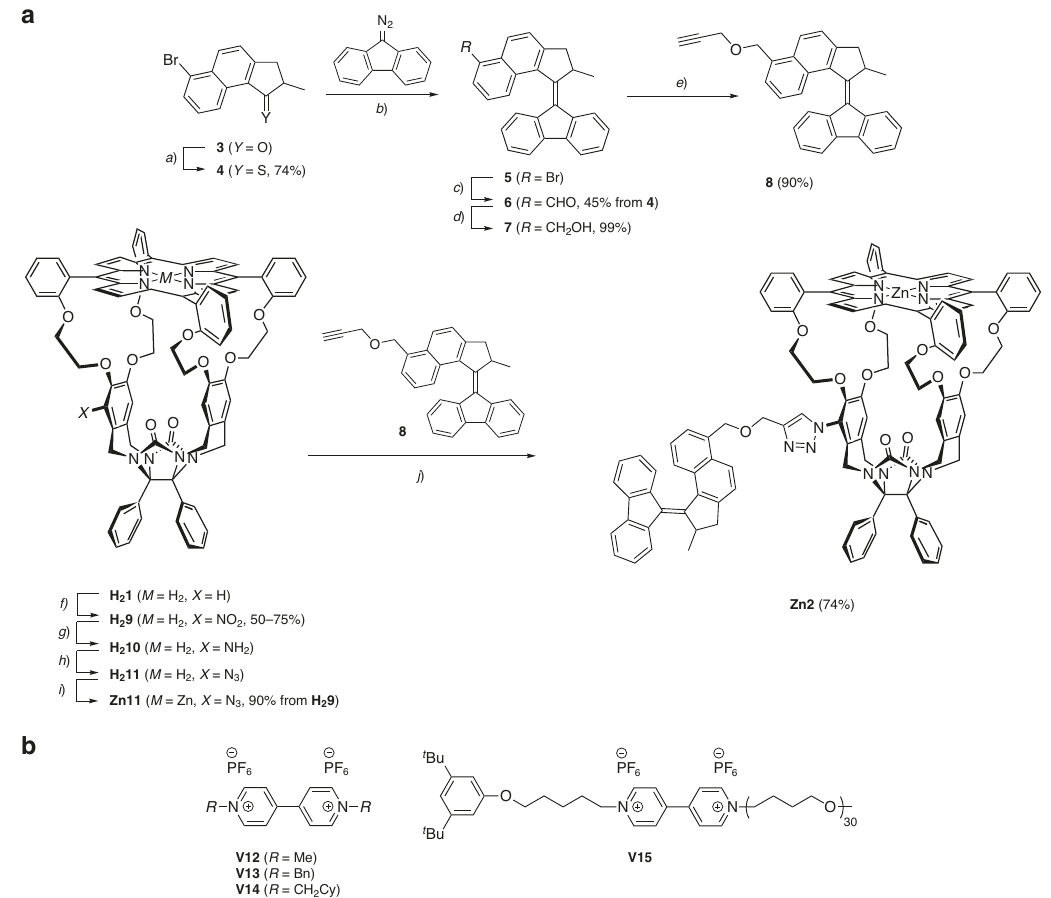
Fig. 2 Synthesis and chemical structures of motor-porphyrin macrocycle conjugate and guests. a Synthesis of Zn2 . Reagents and conditions: a Lawesson ’ s reagent, PhMe, re fl ux, 2 h; b PhMe, re fl ux, 16 h; c n BuLi, THF, − 78 °C, 1 h; then DMF, THF, − 78 °C → 20 °C, 1 h; d NaBH 4 , DCM/MeOH, 20 °C, 15 min; e NaH, THF, 0 °C, 1 h; then propargyl bromide, THF, 0 °C → 20 °C, 21 h; f HNO 3 , CHCl 3 , − 50 °C → − 40 °C, 4 h; g SnCl 2 , HCl, dioxane, 60 °C, 5 h; h t BuONO, TMSN 3 , CHCl 3 /MeCN, 20 °C, 1.5 h; i Zn(OAc) 2 ·2H 2 O, CHCl 3 /MeOH, 20 °C, 20 h; j CuI, DIPEA, DMSO/H 2 O, 20 °C, 3 days. b Structures of viologen guest compounds (Cy =